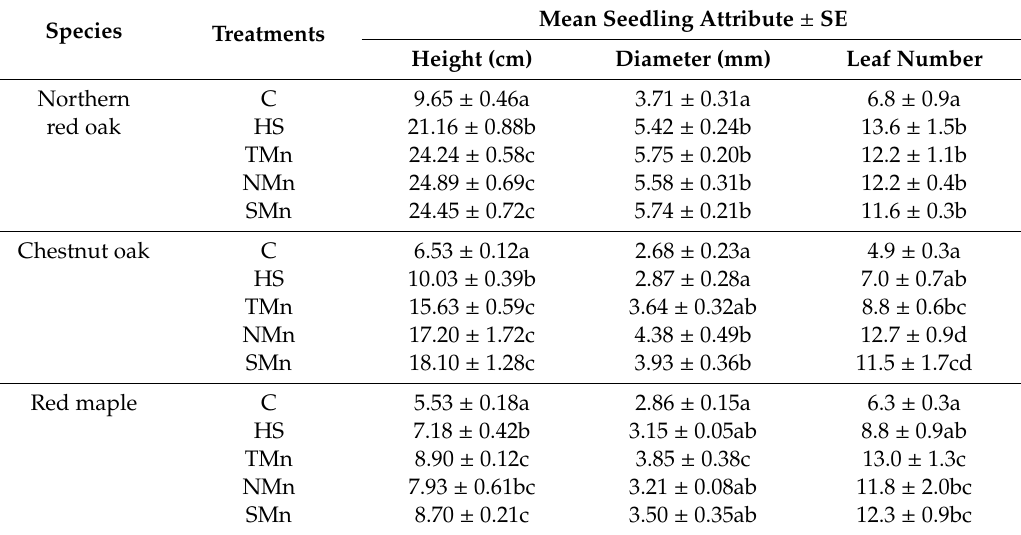
Table 2. Mean 1 of total height, basal diameter, and number of leaves of 12-week-old seedlings by species following treatments 2 of fertilizer with and without